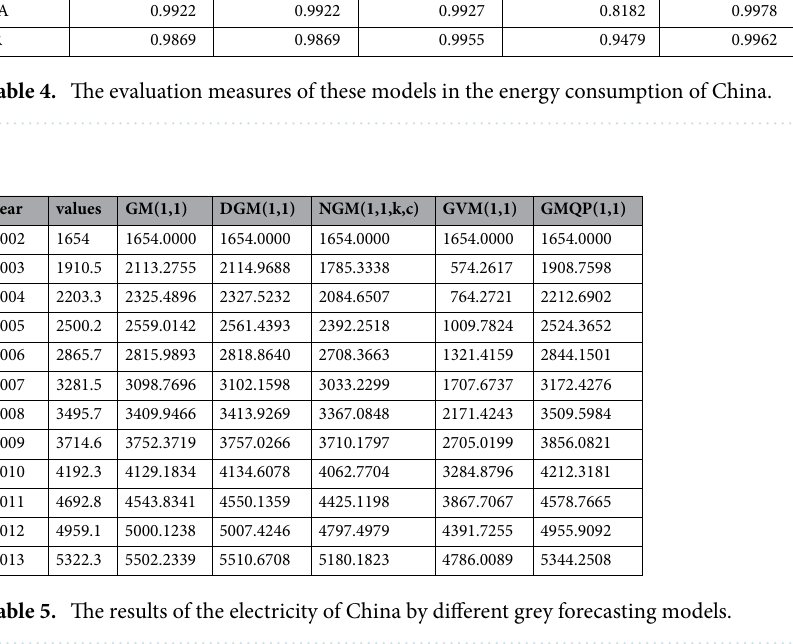
Table 5. The results of the electricity of China by different grey forecasting models.